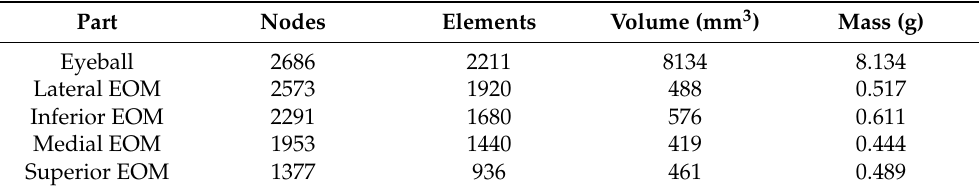
Table 1. Mesh size, volume and mass of the model